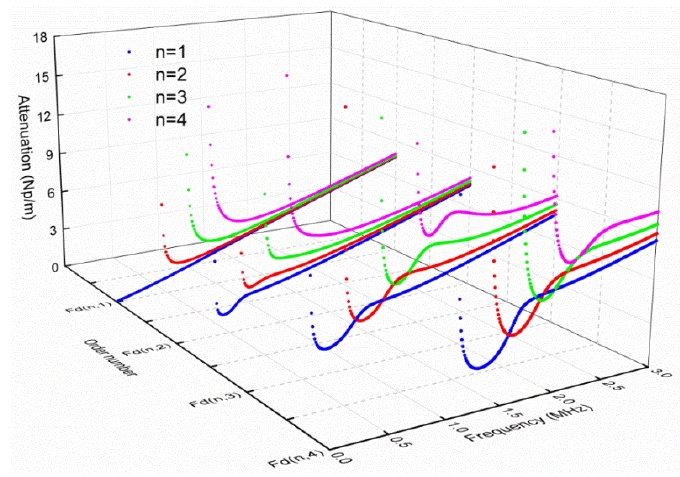
Figure 6. Three dimensional (3D)-attenuation curves for flexural modes.